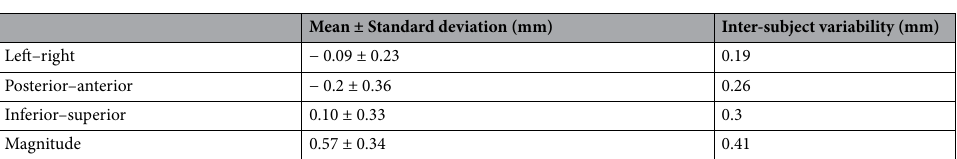
Table 2. Average and standard deviation displacement values in the brain area with the corresponding inter- subject variability. Global statistics are extracted for the three components separately and for the magnitude of